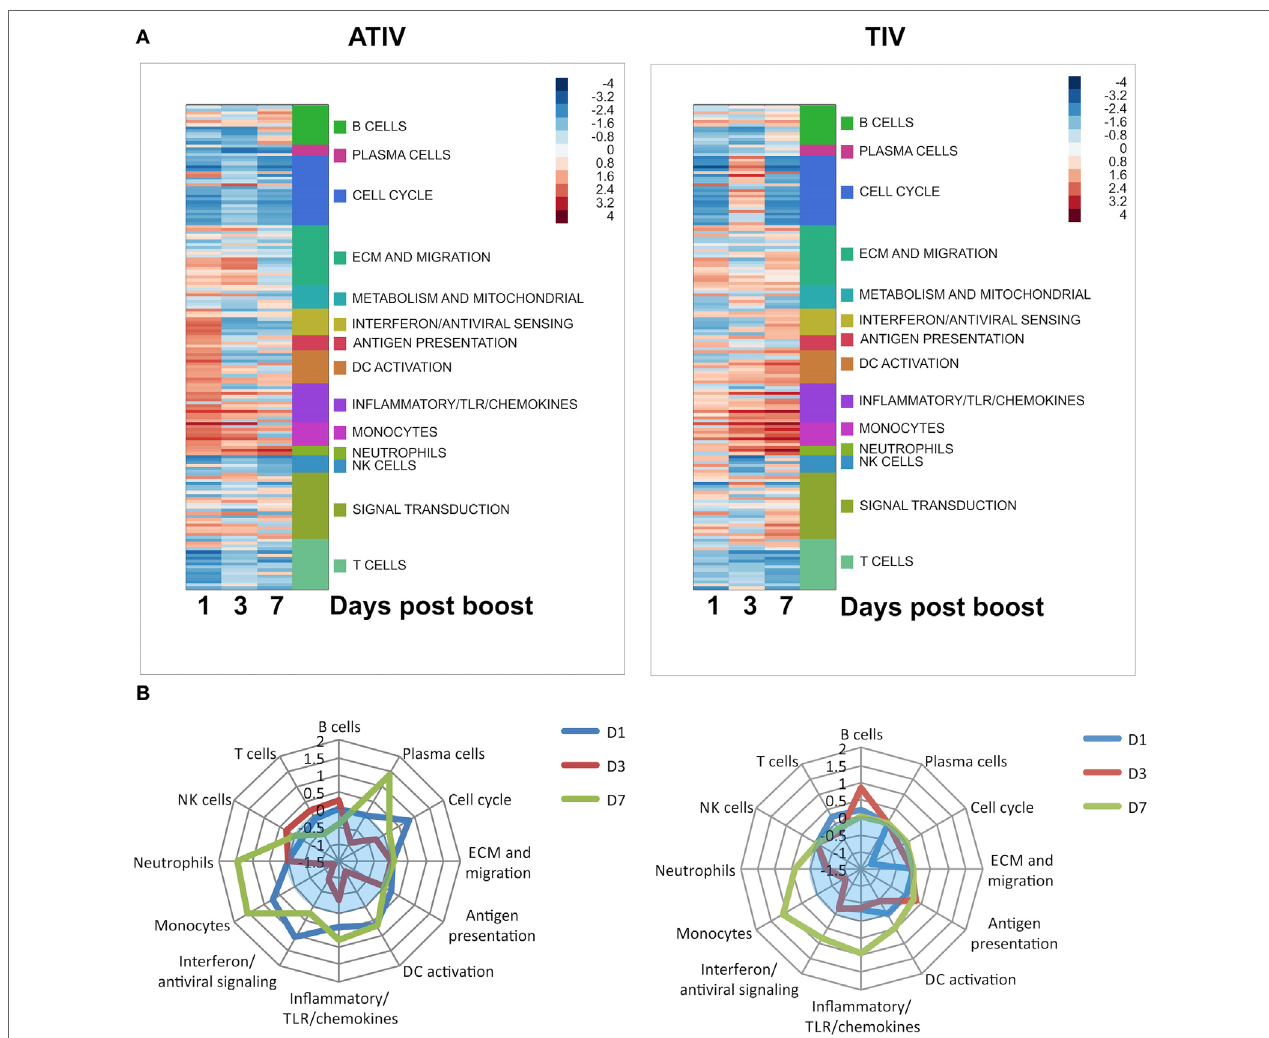
FiGURe 1 | (A) Functional enrichment of transcriptional responses to adjuvanted trivalent influenza vaccine (ATIV) and trivalent influenza vaccine (TIV) vaccination. Enrichment scores generated by the GSEA analysis represented by color panel in right upper corner. Each row represents a module, which are grouped according to the high level notation group, as illustrated on the side bar. Positive enrichment indicates a combined upregulation of genes included in a module. (b) Correlates of immunogenicity (HAI titers) for the ATIV and TIV vaccines. GSEA was performed with genes ranked by correlation of expression to HAI titers. Distance from the center of the spider plot corresponds to the average enrichment score across all modules included in the high level annotation group. Only modules with enrichments significant by p < 0.05 are included; enrichments for insignificantly enriched modules are set to zero. Blue translucent zones indicate negative